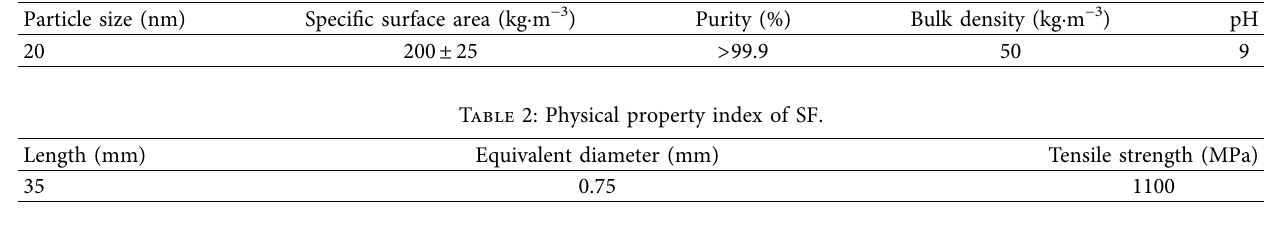
Table 1: Physical property index of NS.